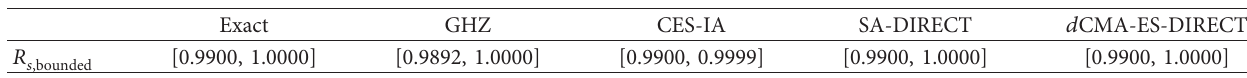
Table 4: The intervals of R s on the exact, GHZ, CES-IA, SA-DIRECT, and